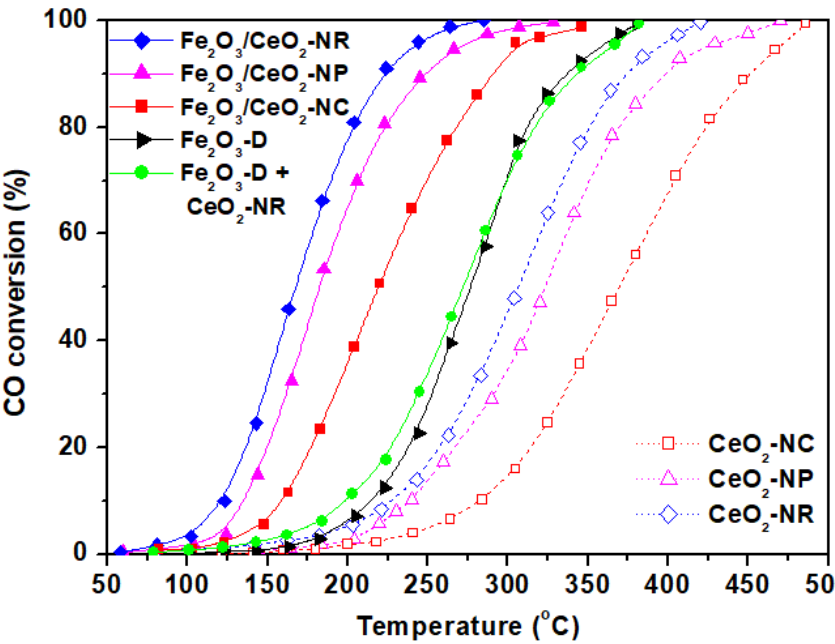
Figure 7. CO conversion as a function of temperature for bare CeO 2 and Fe 2 O 3 / CeO 2 samples of different morphology (NR, NC, and NP, as indicated in each curve). Reaction conditions: 2000 ppm CO, 1 vol.% O 2 , Gas Hourly Space Velocity (GHSV) = 40,000 h − 1 .